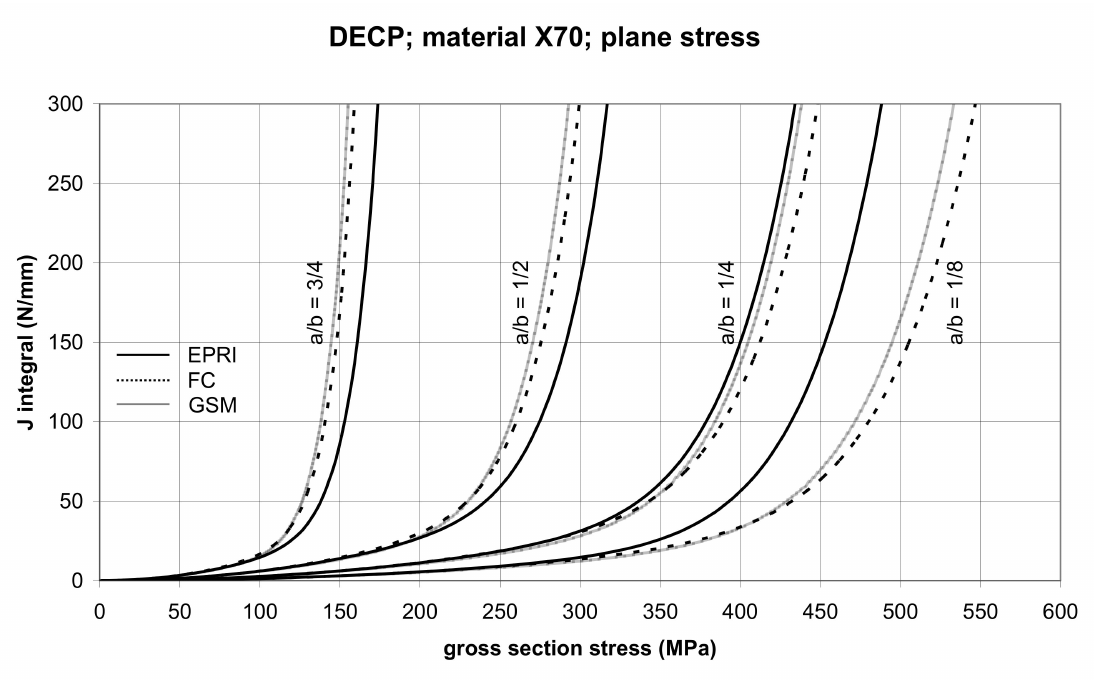
Figure 12. Comparison of J integral for DECP X70 steel specimens in the plane stress condition as determined by the EPRI, GSM, and FC methods.